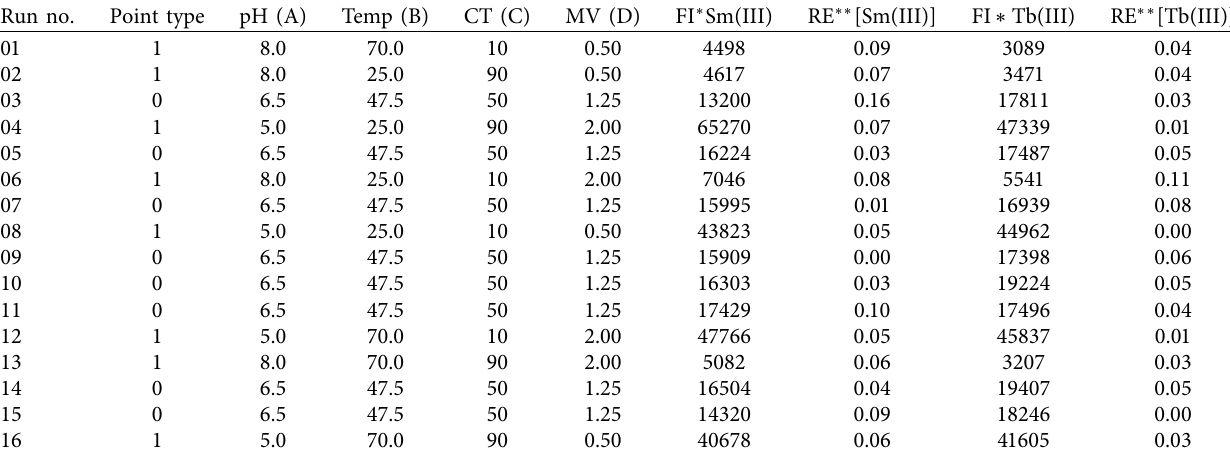
Table 2: Experimental setup employing PBD.